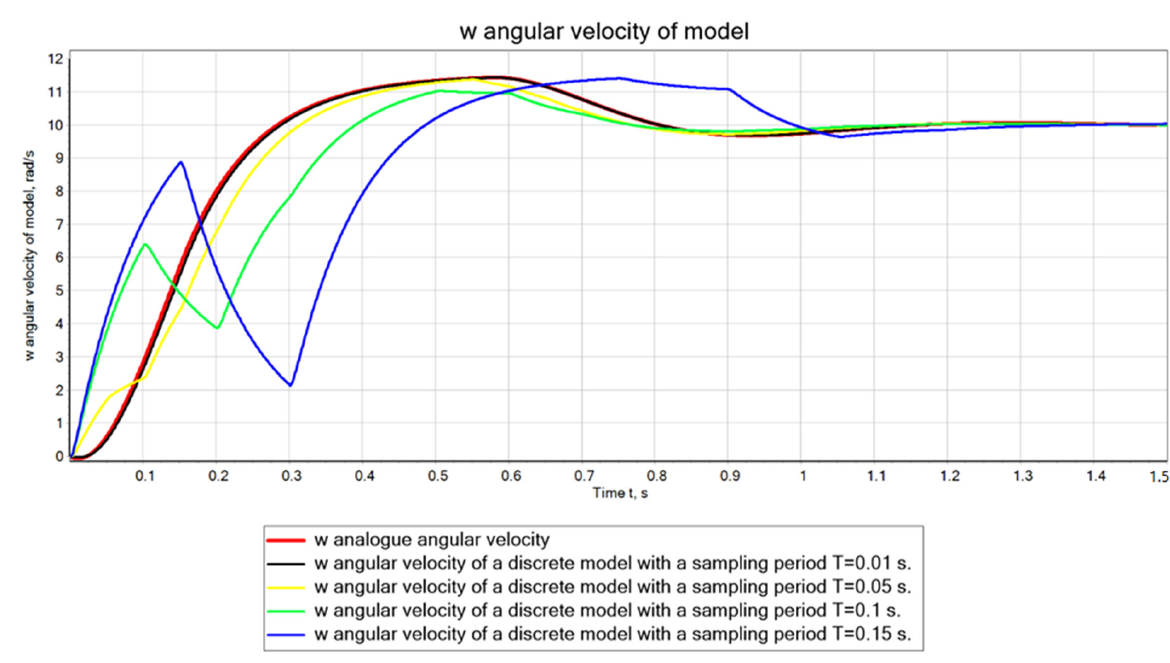
Figure 10. Transient plots in continuous and continuous-discrete actuator